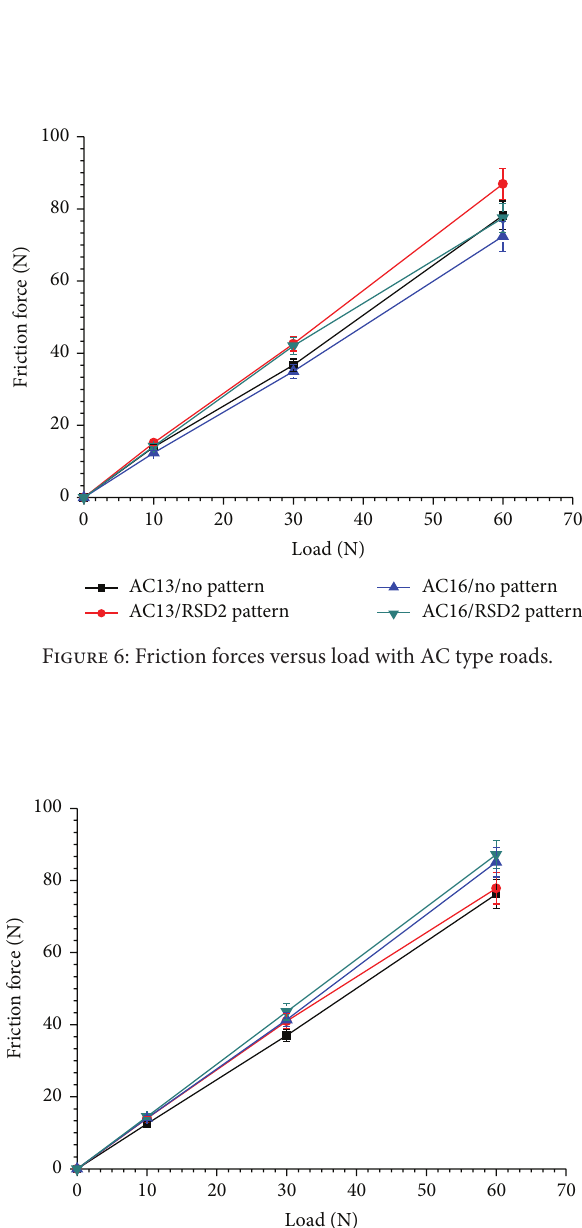
Figure 5: Elastic contact between a flat rubber surface and a hard solid substrate [17].